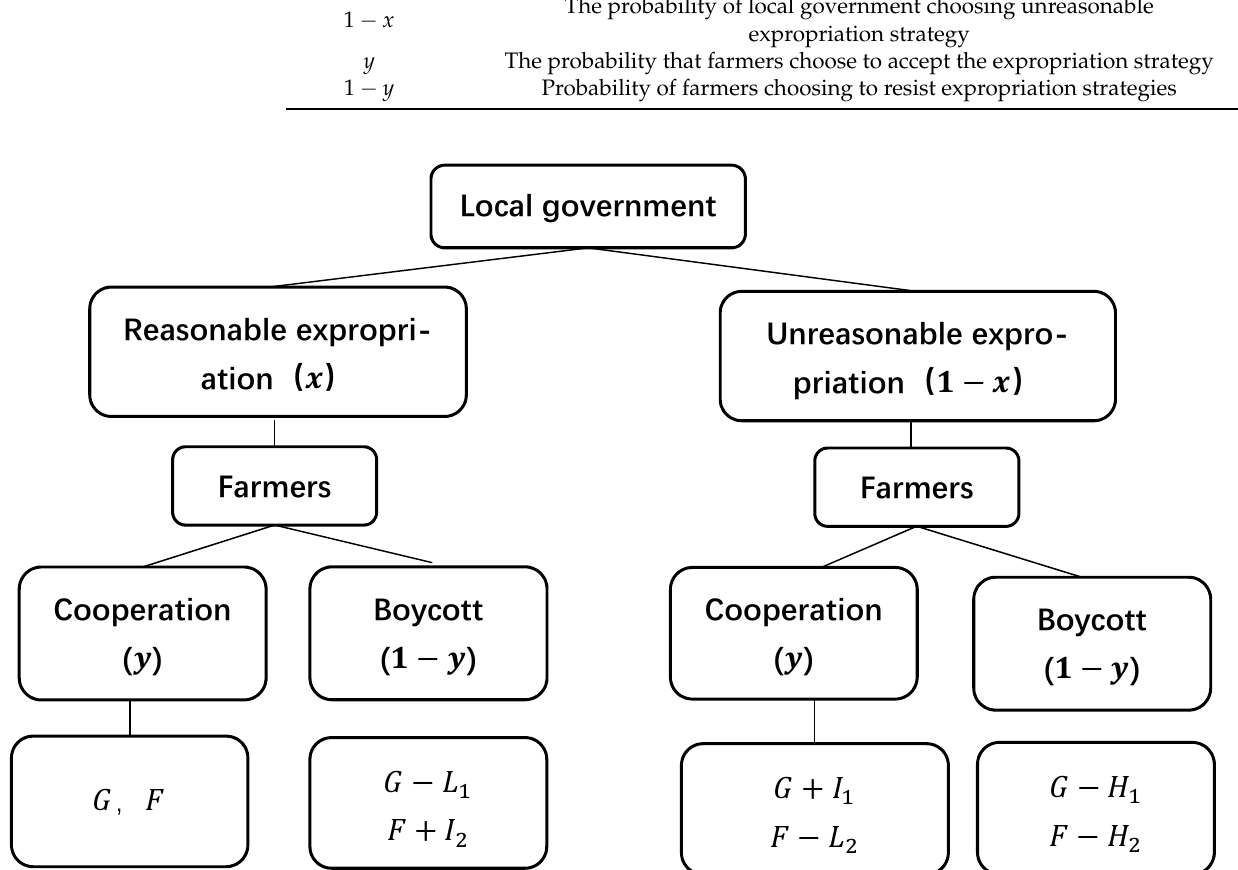
Figure 1. Dynamic game payment matrix of land expropriation conflict under complete self-interest preference. Table 1. Model Parameter Description.